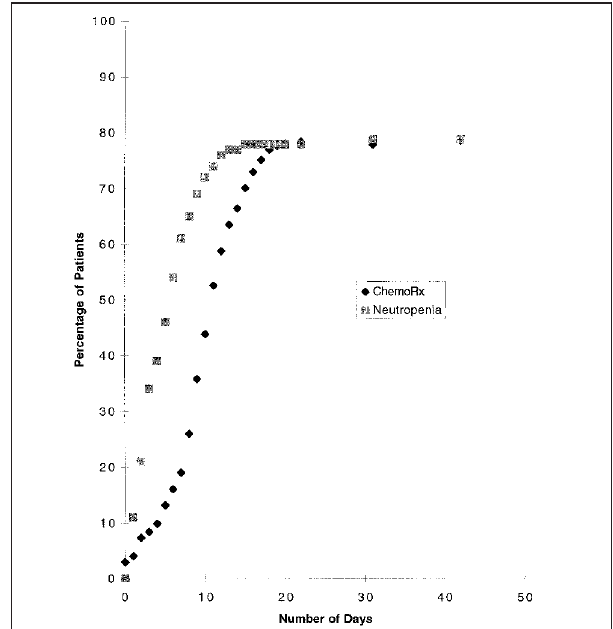
Figure 1) Proportion of febrile patients relative to the first day of che- motherapy and the first day of neutropenia